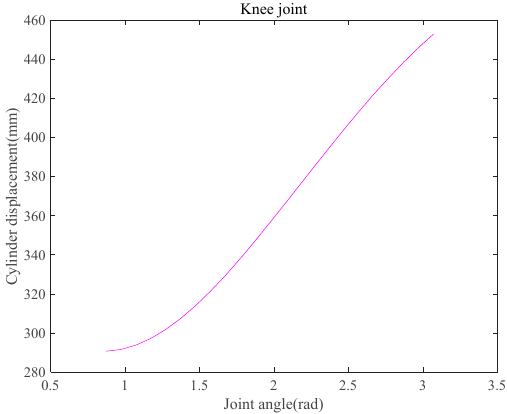
Figure 5. Relationship curve between cylinder displacement and joint angle.